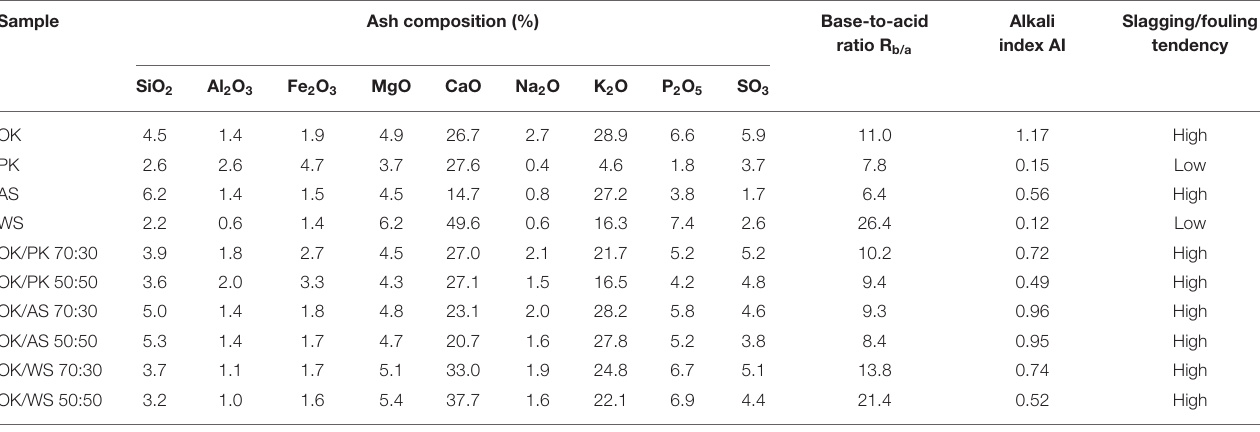
TABLE 2 | Chemical analysis of raw material ashes and slagging/fouling tendency. Sample